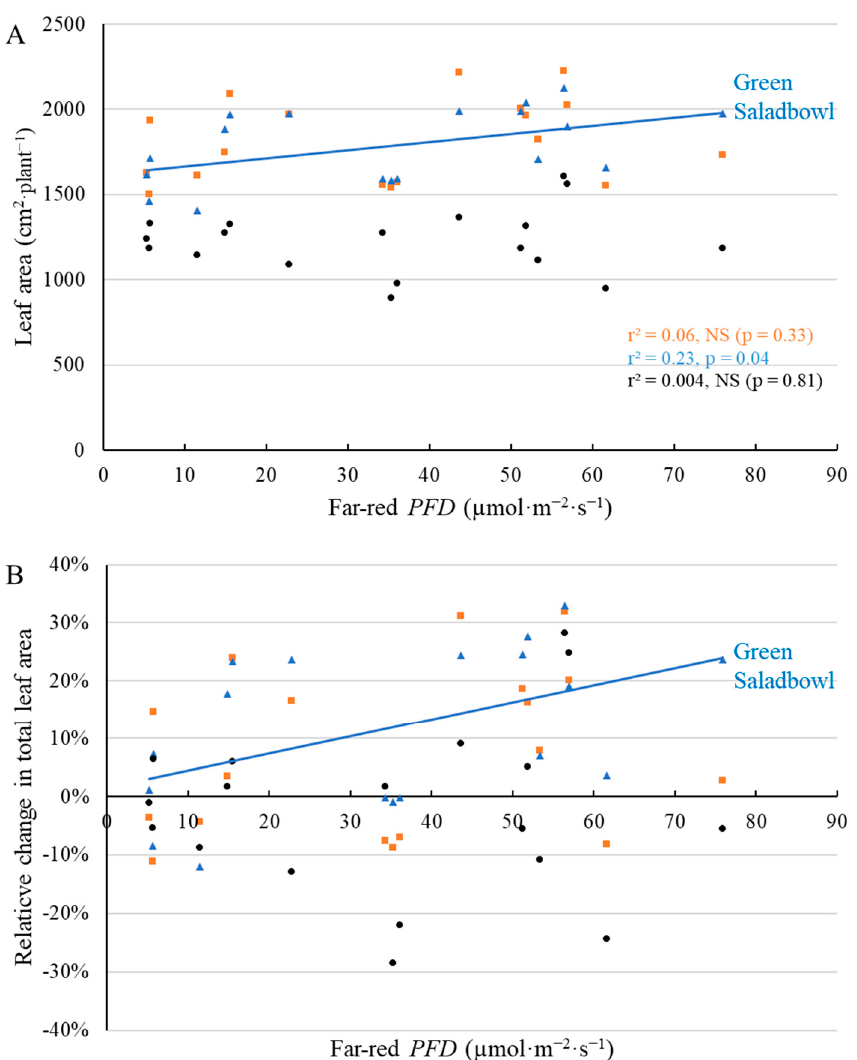
Figure 5. With a background of 204 µ mol · m − 2 · s − 1 white LED light, supplemental far-red photons linearly increased total leaf area ( A ) and the relative change in total leaf area (( B ), compared to plants without supplemental far-red light) 35 days after the start of far-red light treatment for ‘Green Saladbowl’ lettuce, but not for ‘Cherokee’ (orange squares) and ‘Little Gem’ (black dots). The r 2 and p values for regression of each cultivar apply to both graphs and are shown with the respective color.